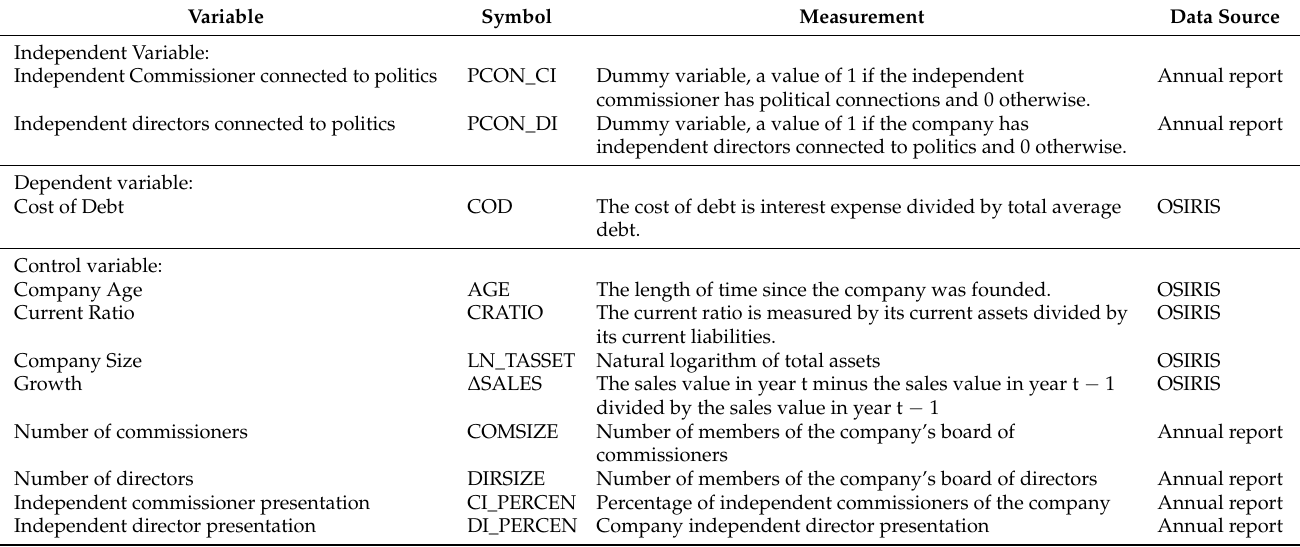
Table 1. Variable Definition and